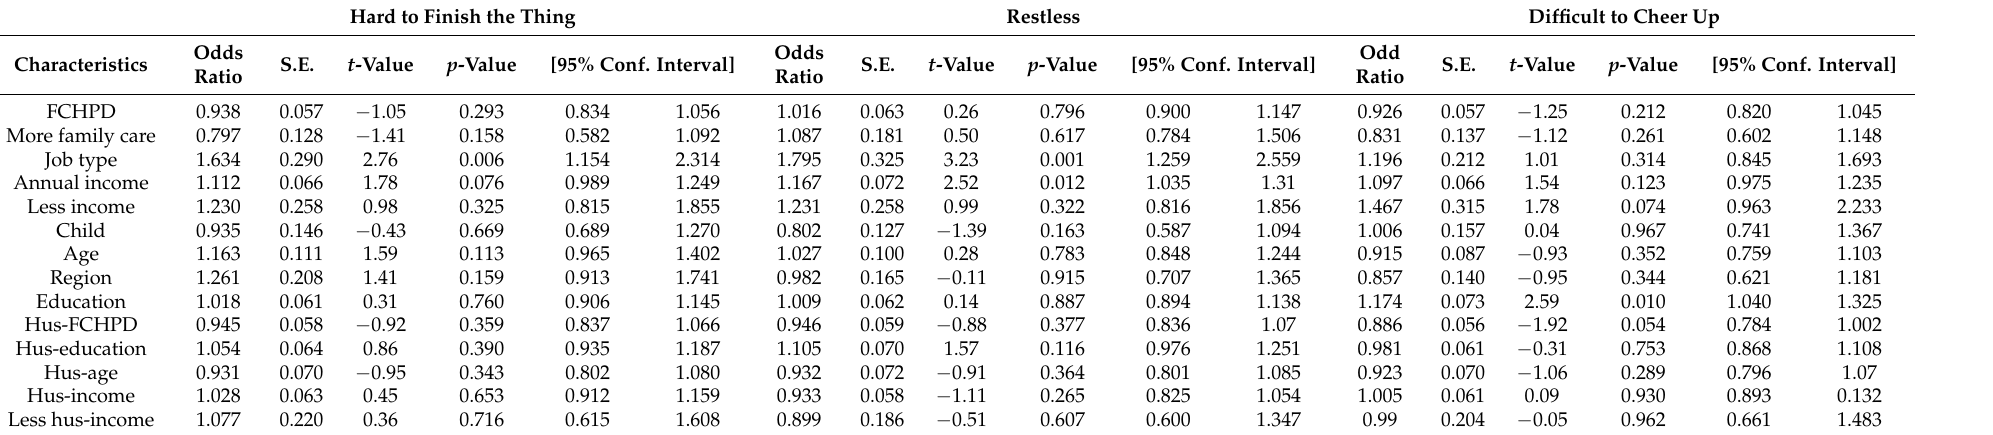
Table A2. Ordinal logistic regression of “hard to finish the thing”, “restless”, “difficult to cheer up” partially with different factors in the total sample. Hard to Finish the Thing Restless Difficult to Cheer Up